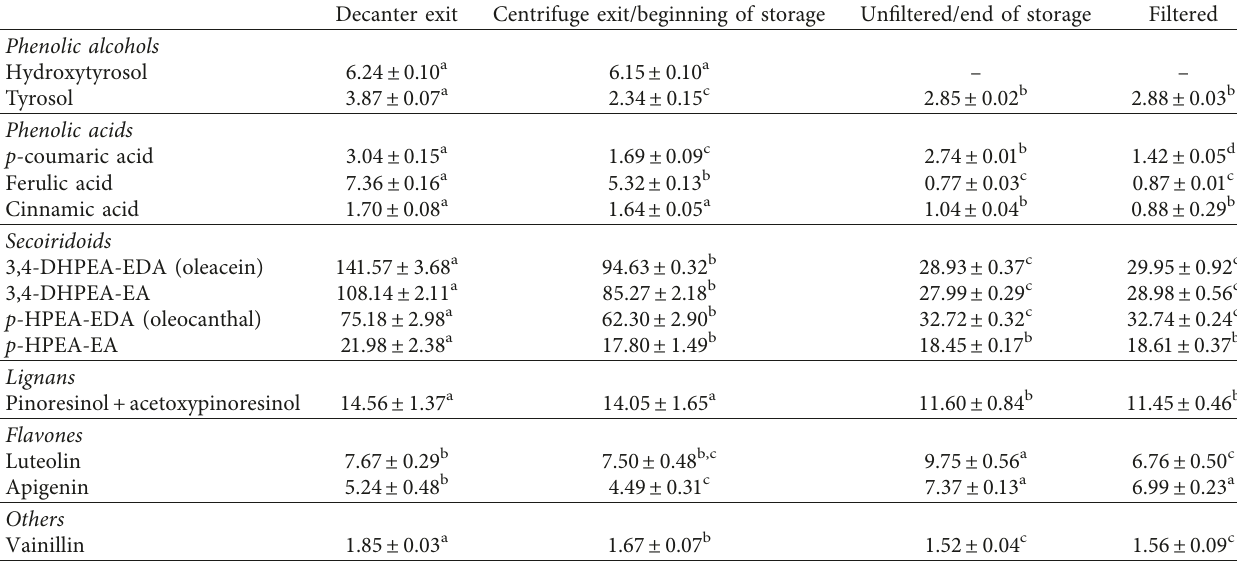
Table 3: Individual content of phenolic compounds before and after vertical centrifugation, storage, and filtration, expressed in mg/kg